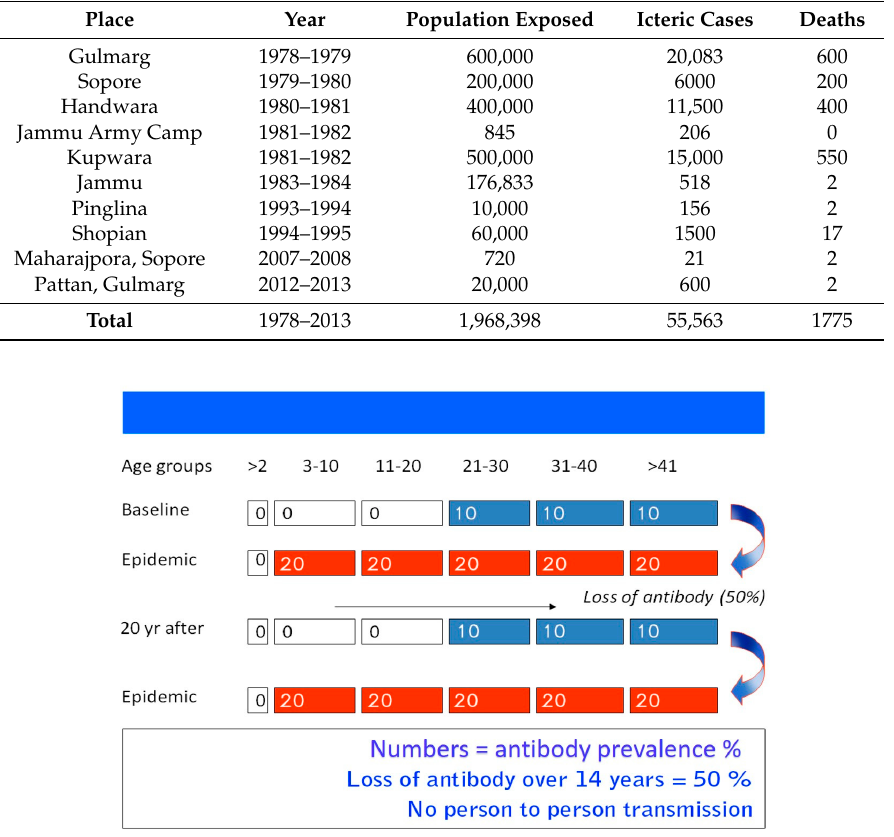
Table 1. Account of 10 periodic epidemics recorded in Kashmir, India from 1978 to 2013.